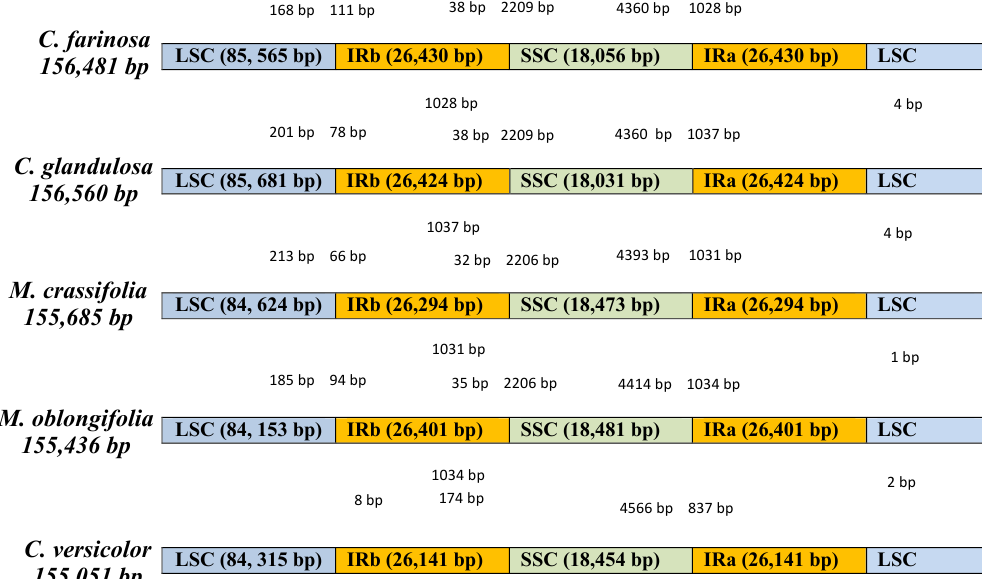
Figure 7. Comparison of the IR, SSC and LSC junction positions among five chloroplast genomes of